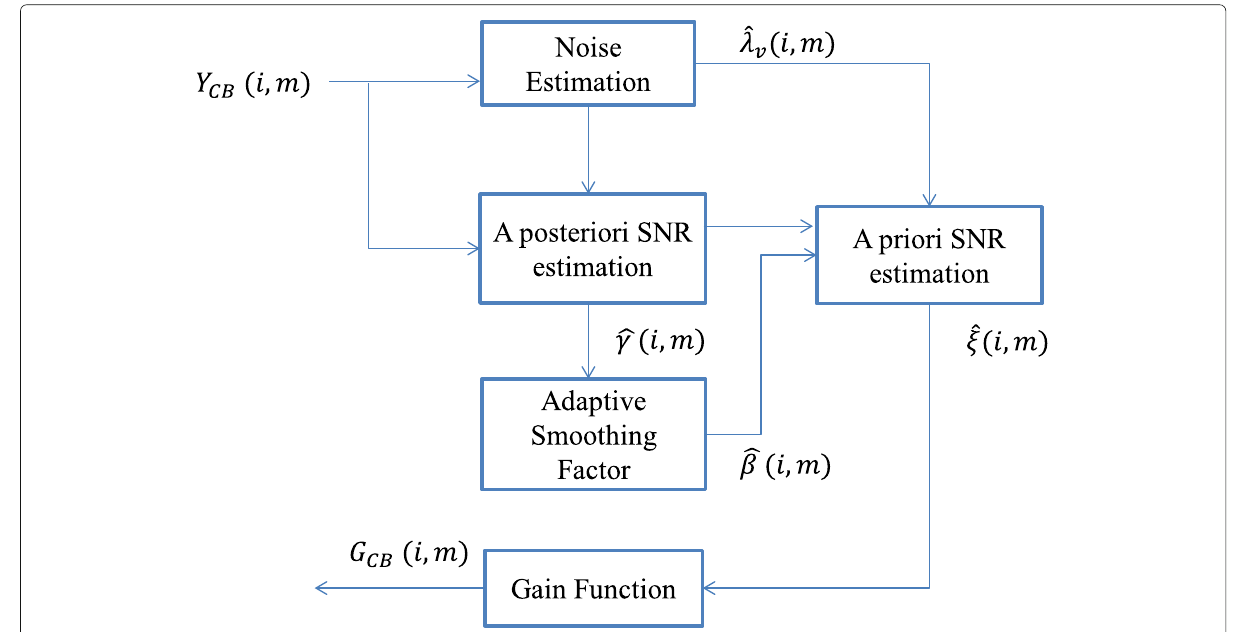
Fig. 2 Block diagram of the spectral gain function computation using the proposed a priori SNR estimation